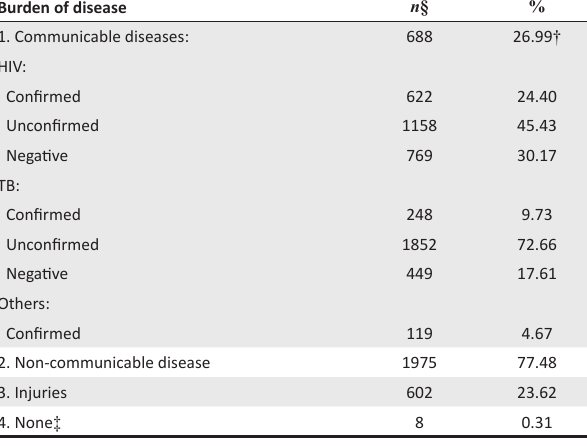
TABLE 3: Speech-language therapy diagnosis ( n = 2549).